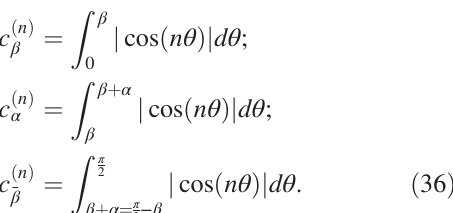
ˆ f of 0 at their relative